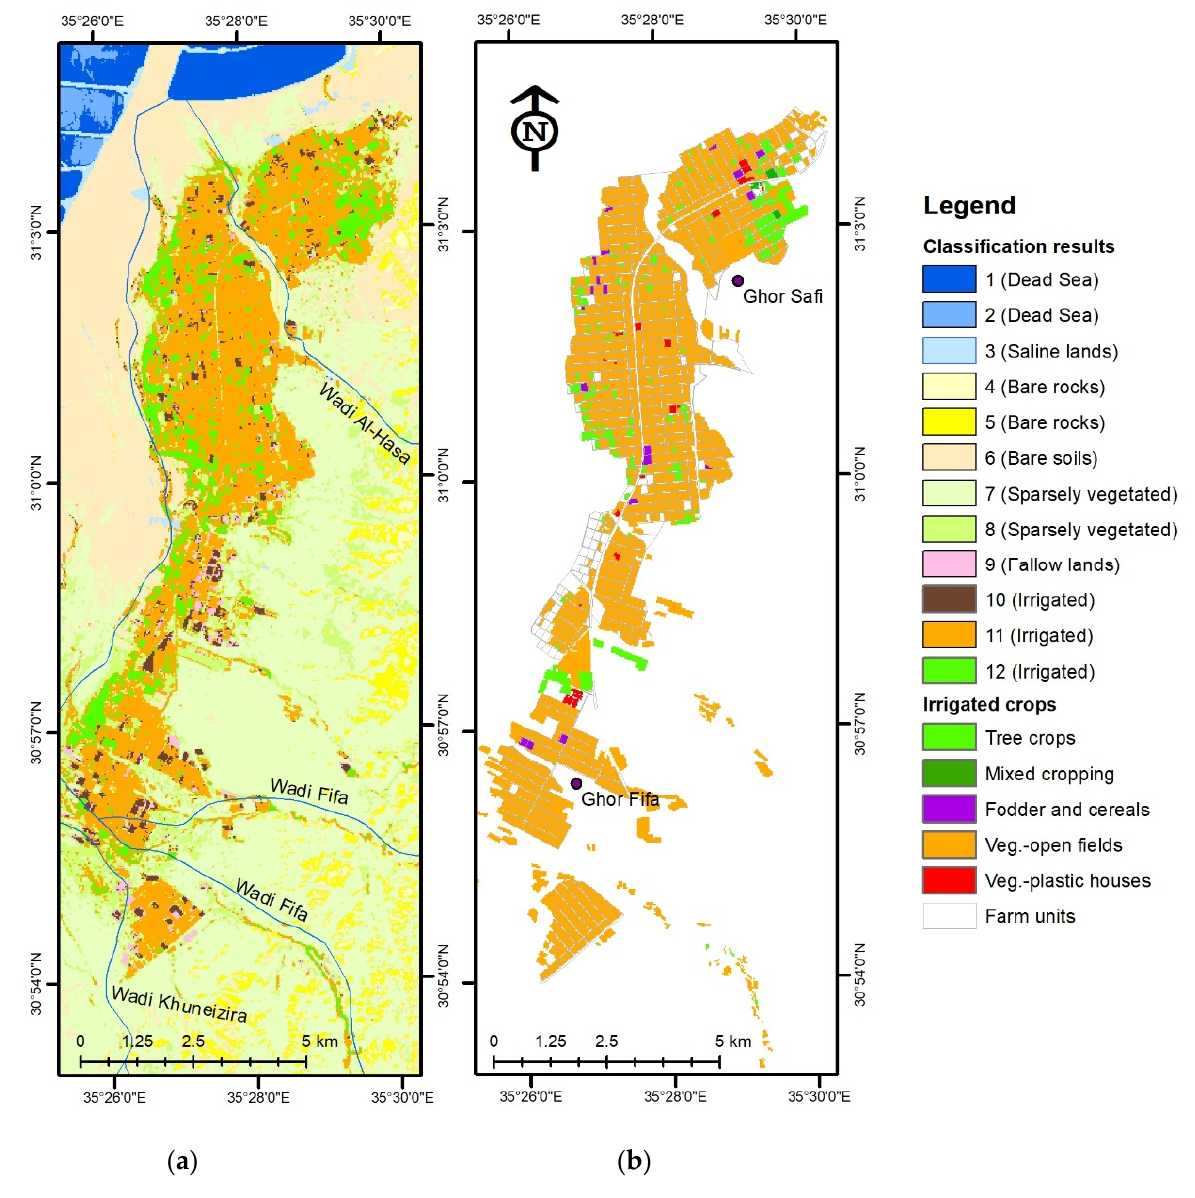
Figure 5. Mapping of irrigated crops in Ghor As-Safi. ( a ) Results of the unsupervised classification of the multi-temporal NDVI images; ( b ) Final map of irrigated crops after editing, merging of ground data, and applying different GIS overlay functions.